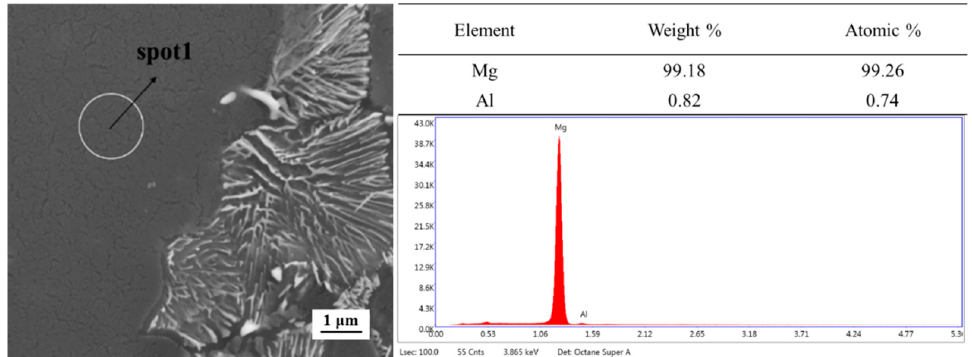
Figure 4. SEM image and the representative point EDS spectrum along with the analysis results of